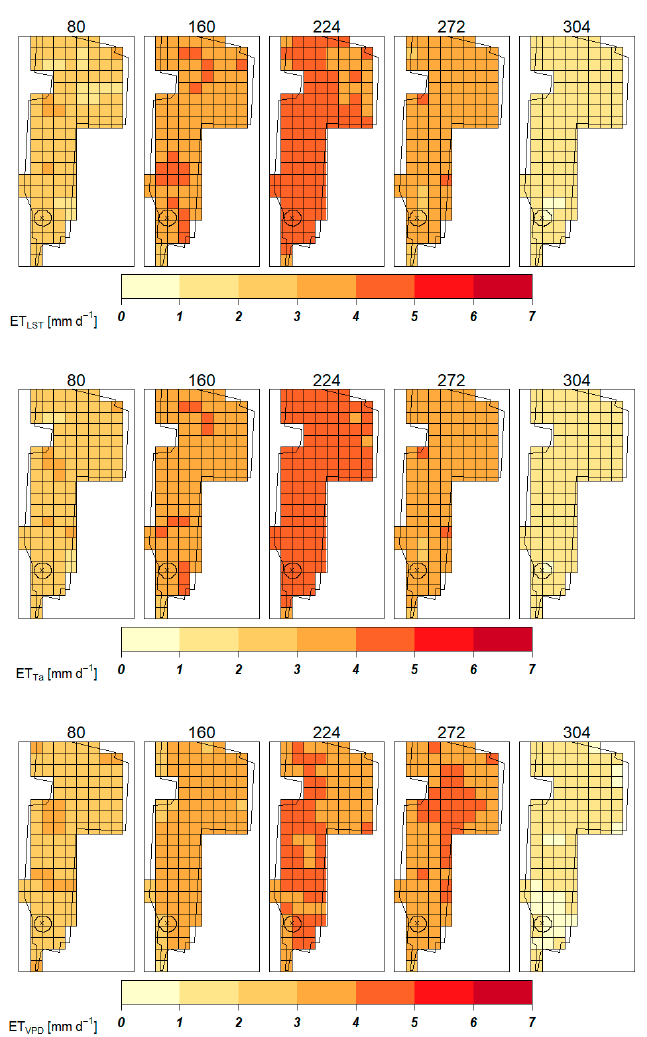
Figure 6. Modeled daily ET for the whole vineyard in 2011 from DOY 80 − 304 as calculated from EVI in conjunction with LST (ET LST ), Ta (ET Ta ), and VPD (ET VPD ), respectively. The cross shows the position of the EC system with the 80% footprint area around the EC station.